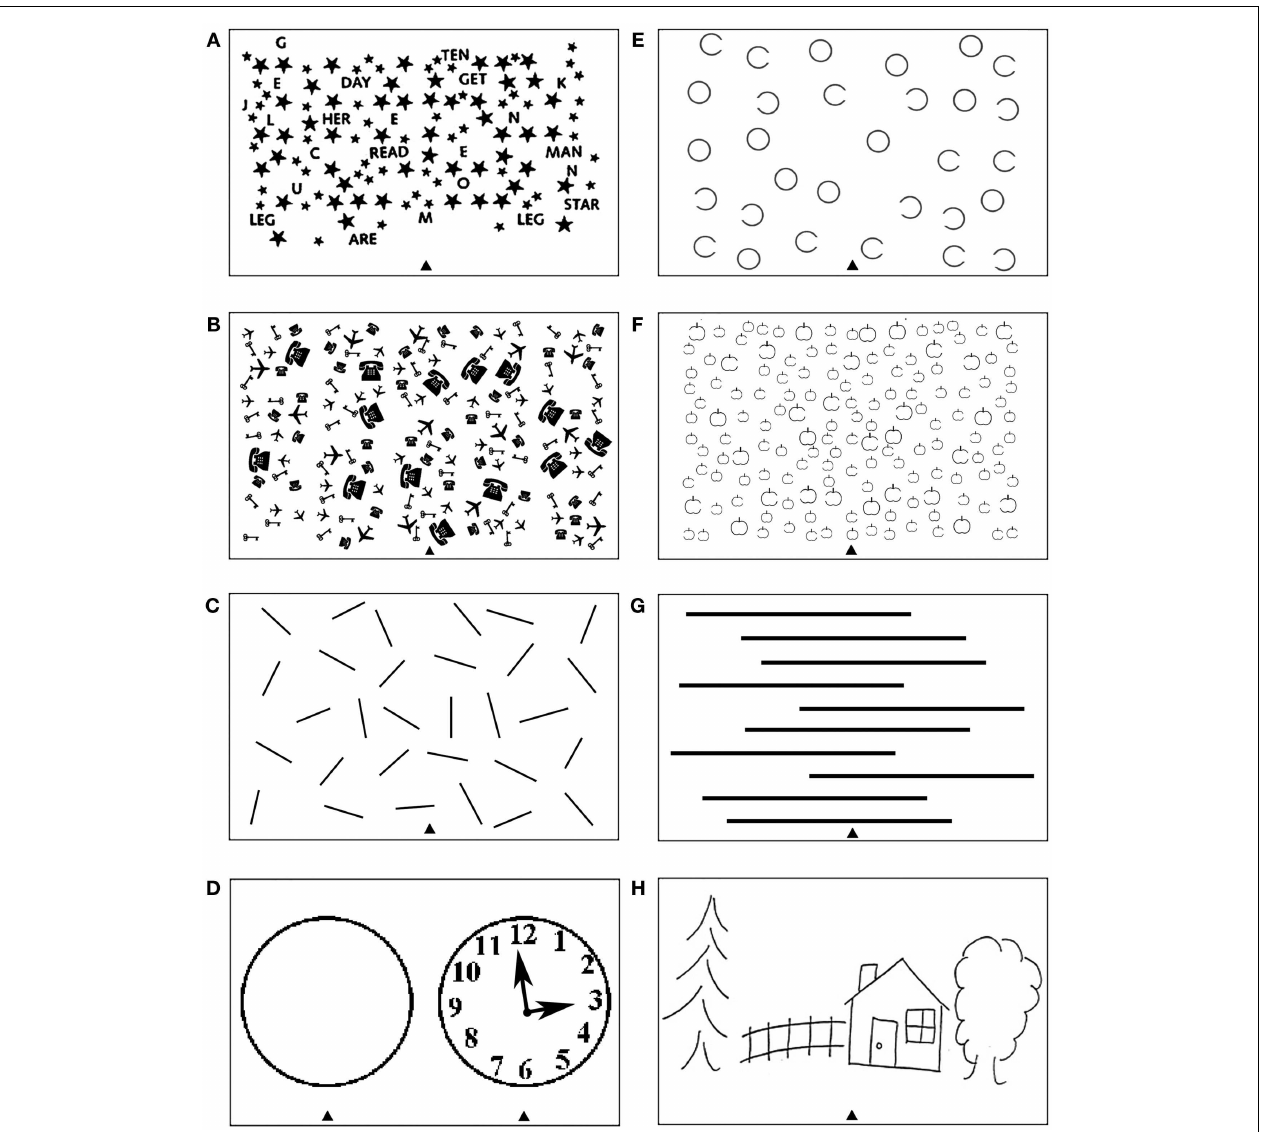
FIGURE 1 | Examples of tests frequently used to diagnose heterogeneous symptoms associated with unilateral visual neglect, which can provide measure of deficits associated with impaired control of attention either (A–D) across space, i.e., egocentric frame of reference and/or (E–H) within objects, i.e., allocentric frame of reference (see Introduction for further details). Common cancelation tests: (A) star cancelation, (B) key cancelation, and (C) line crossing, all administered by asking patients to cross targets (small stars, keys, or lines respectively) evenly distributed on the centrally placed sheet of paper – deficits are measured by target omissions on either left or right side of space. (D) Clock drawing test that can be administered by either asking patients to place numbers on the face of the clock or asking patients to copy the fully drawn clock (the face of the clock or fully drawn clock are centrally presented on the sheet of